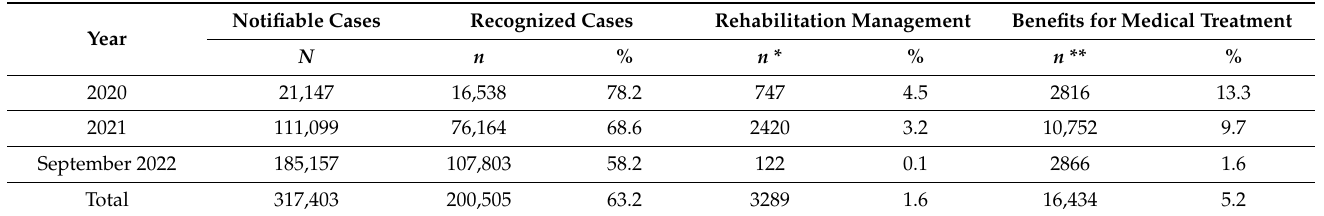
Table 1. Notifiable and recognized occupational diseases due to COVID-19, as well as the number of cases in rehabilitation management and cases with medical treatment, separated by year of reporting.